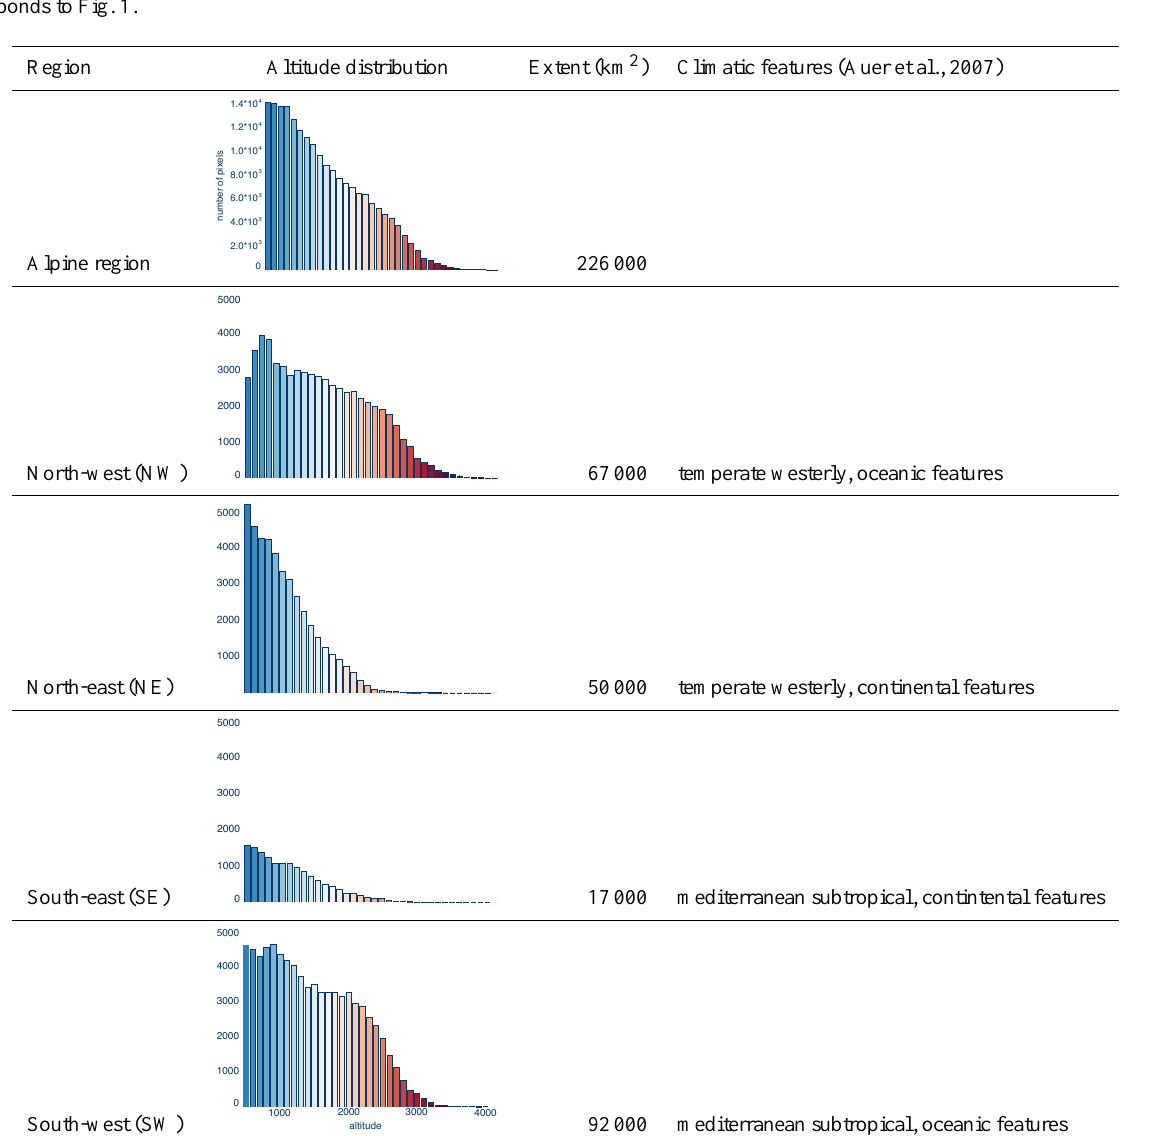
Table 1. Distinct properties of the Alps and its subregions in terms of altitude distribution, extent and climatic influence. Color encoding corresponds to Fig. 1. Region Altitude distribution Extent (km 2 ) Climatic features (Auer et al., 2007)